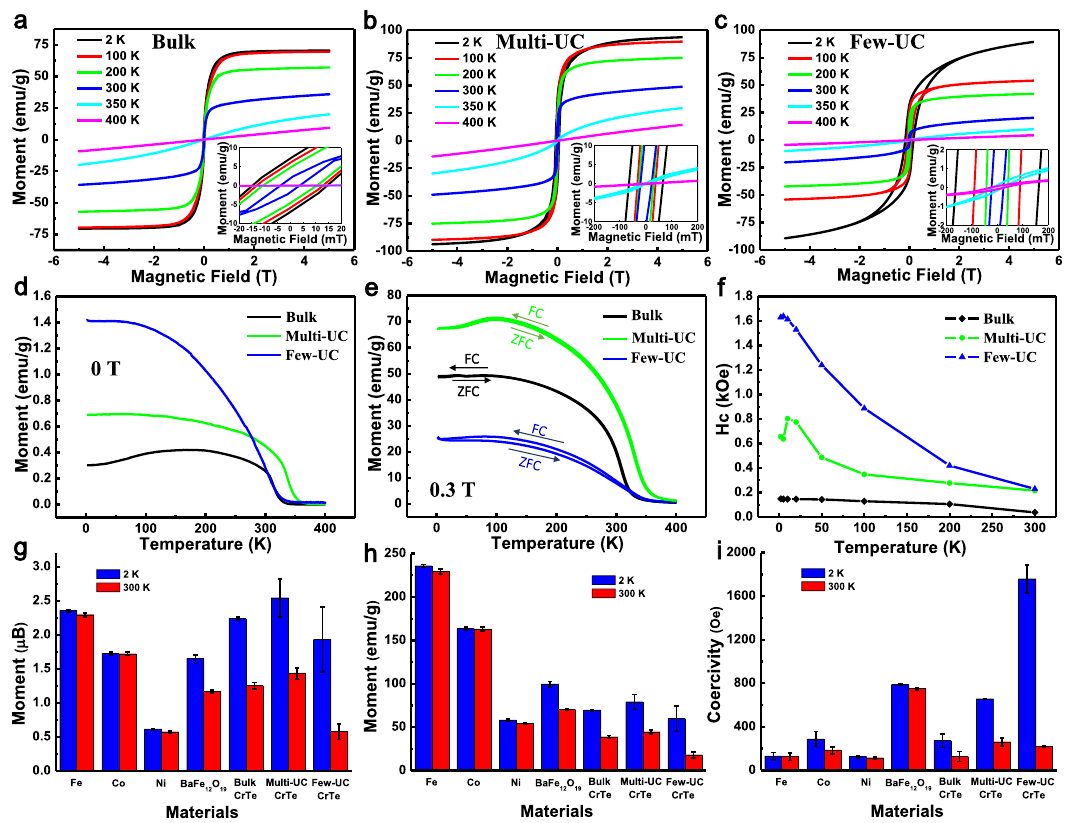
Fig. 3 Ferromagnetic properties of bulk, multi-UC, and few-UC CrTe crystals. a – c M – H hysteresis of bulk, multi-UC, and few-UC CrTe crystals from 2 to 400 K. d Spontaneous magnetization without magnetic fi eld ( B = 0) for bulk, multi-UC, and few-UC CrTe crystals from 2 to 400 K. e Temperature dependences of moment (M – T) for bulk, multi-UC, and few-UC CrTe from 400 to 2 K with 0.3 T magnetic fi eld using ZFC and FC tests. f Temperature dependences of coercivity (Hc) for bulk, multi-UC, and few-UC CrTe crystals from 2 to 300 K. g – i Saturation magnetic moment ( g , h ) and coercivity ( i ) comparison of bulk, multi-UC, and few-UC CrTe crystals with Fe, Co, Ni, and BaFe 12 O 19 . Error bars s.e.m., N = 3; see original data in Supplementary Table 1 and notes in Supplementary